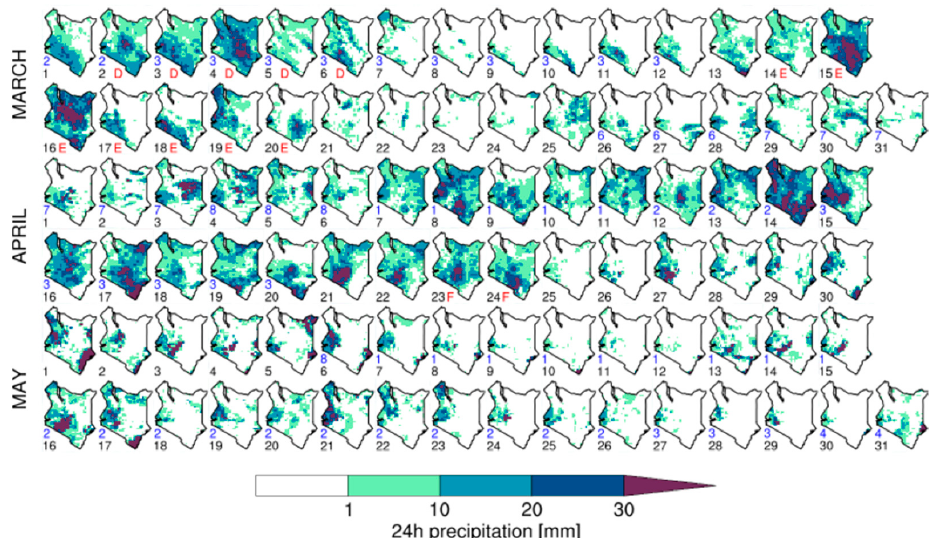
Figure 3. CHIRPS daily rainfall over Kenya during MAM. The lower number in the bottom left of each panel indicates the date, and the upper number indicates the concurrent phase of the MJO (only ‘active’ days with MJO index greater than one are shown). The letters D, E, and F indicate days when tropical cyclones/storms Dumazile, Eliakim, and Fakir were active near Madagascar (tropical depression or greater, based on data from http://www.meteo.fr/temps/domtom/La_Reunion/webcmrs9.0/anglais/index.html). Atmosphere 2018 , 9 , x FOR PEER REVIEW